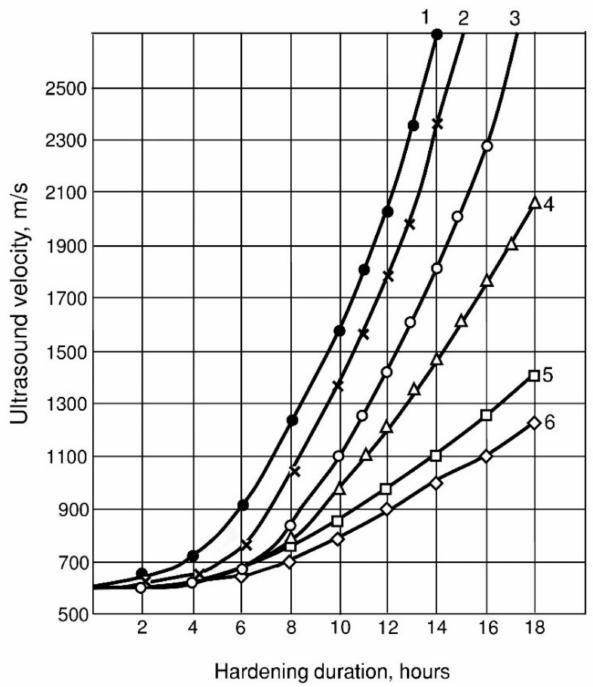
Figure 7. Kinetics of ultrasound velocity through cement-water pastes: 1—X 1 = 1; X 2 = 0.2; X 4 =